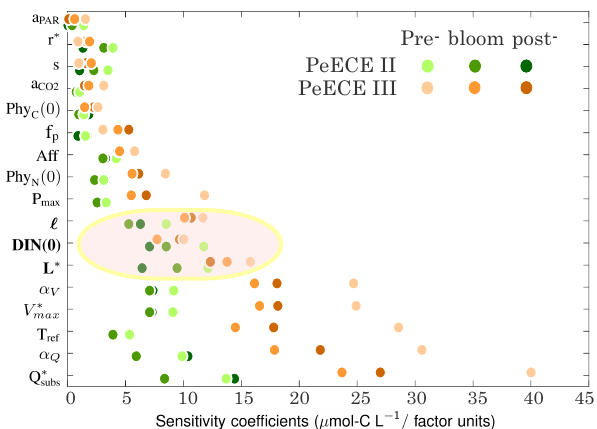
Figure 7. Sensitivity coefficients ( ε i ; Eq. 2) of factors φ i listed in Tables 1 and 2 for different bloom phases in two OA-independent mesocosm experiments. Factors whose uncertainties potentially mask acidification effects (Fig. 4) by triggering variability during the bloom (Figs. 5 and 6) are